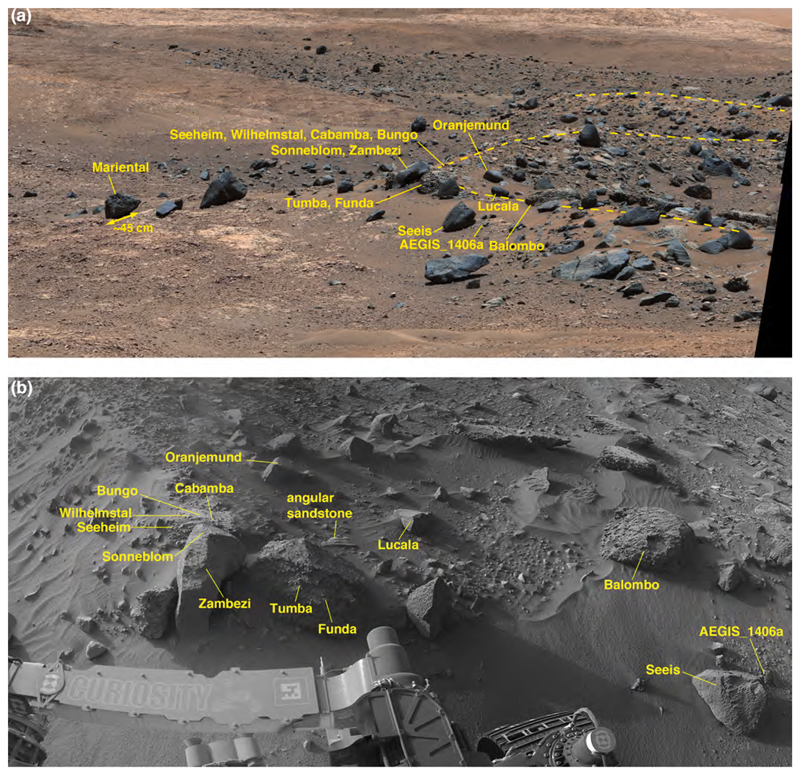
a) Work site for sols 1405–1410, viewed from the east. Names of targets investigated using ChemCam, Mastcam, APXS, and MAHLI are indicated. The dashed trace approximately indicates the crest of a low ridge line that defines the southern margins of Bimbe. (b) Navcam view of the work site. ChemCam, APXS, and MAHLI targets are indicated (except Mariental, which is to the left of this scene). The stone labeled “angular sandstone,” imaged by MAHLI on Sol 1407, is also shown in Fig. 15 and was not a named target. For scale, the width of the rover wheel (right of lower center) is 40 cm.